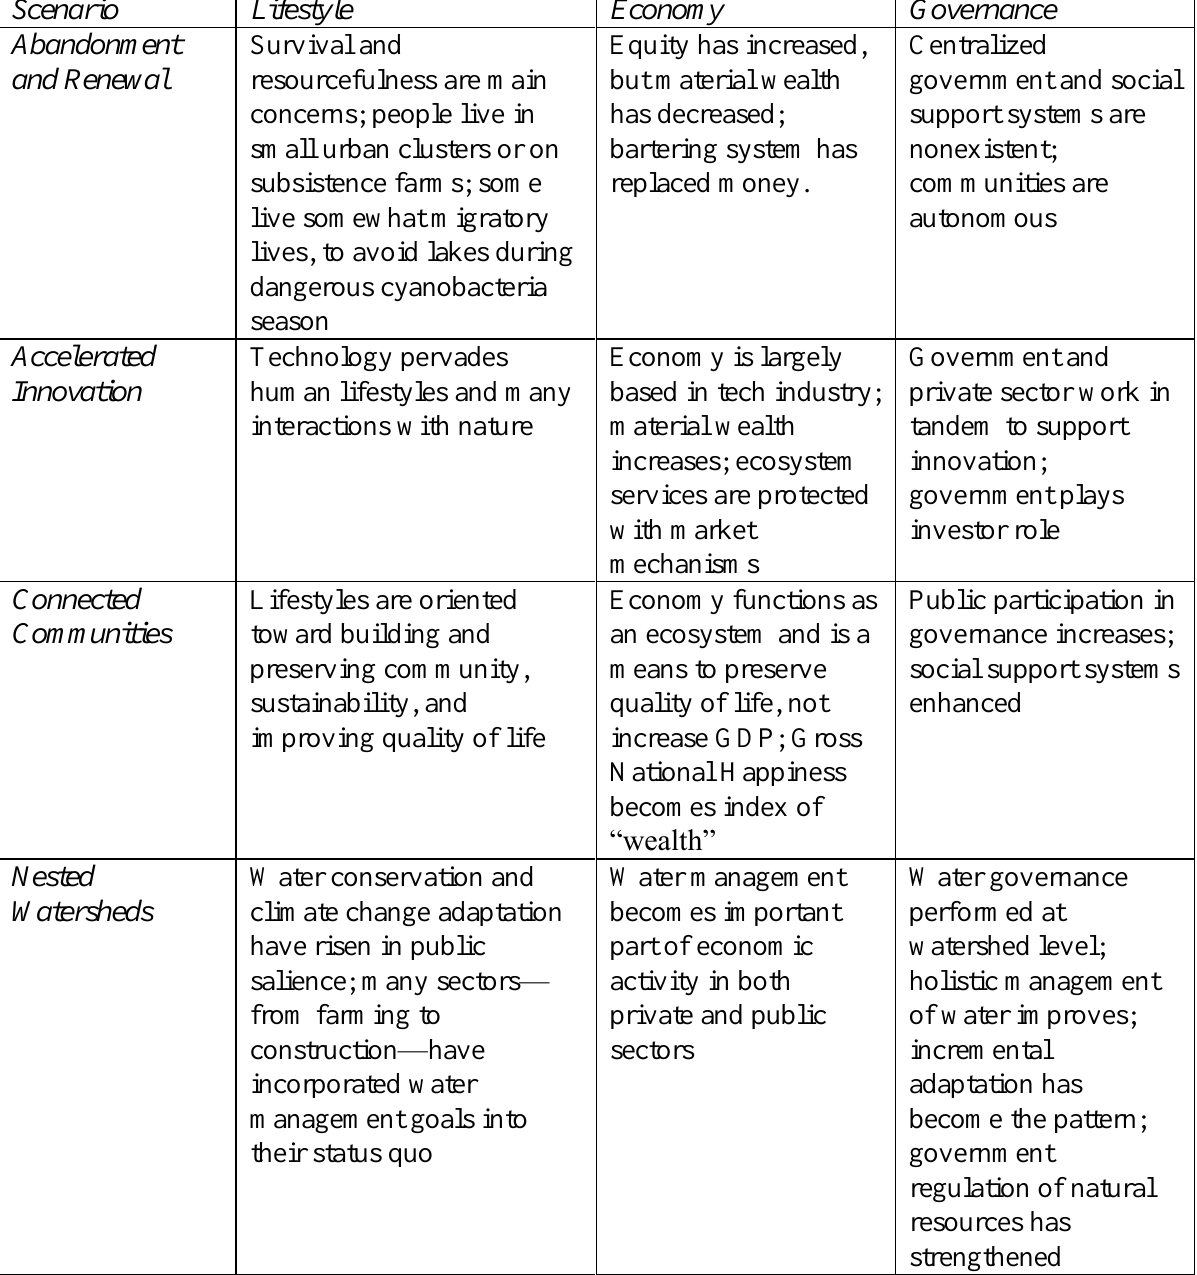
Table A1.3. Social Outcomes in 2070